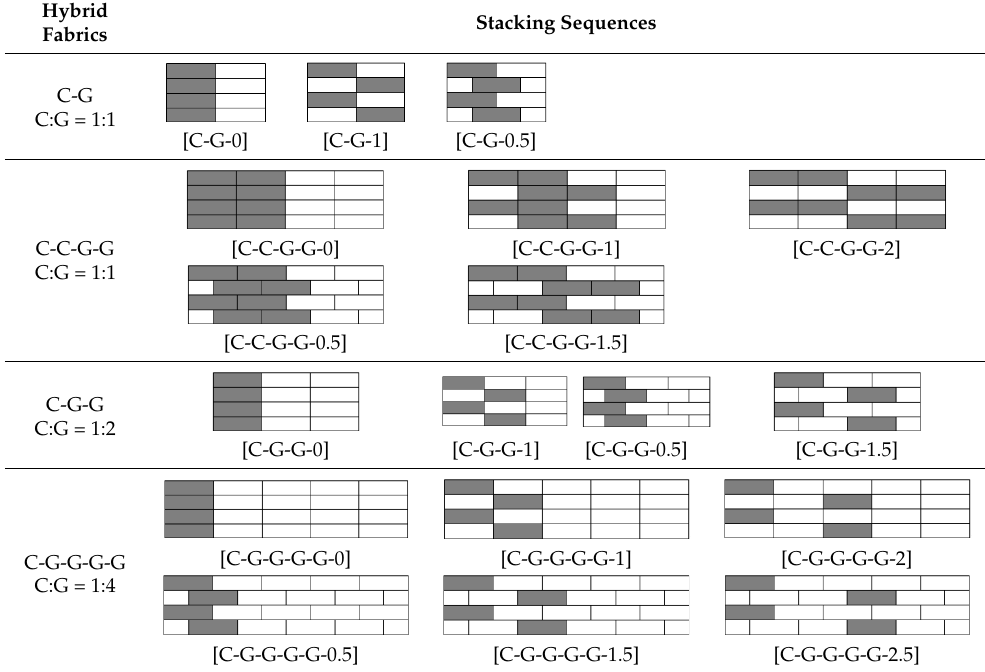
Table 4. Stacking configurations of intralayer hybrid structures.